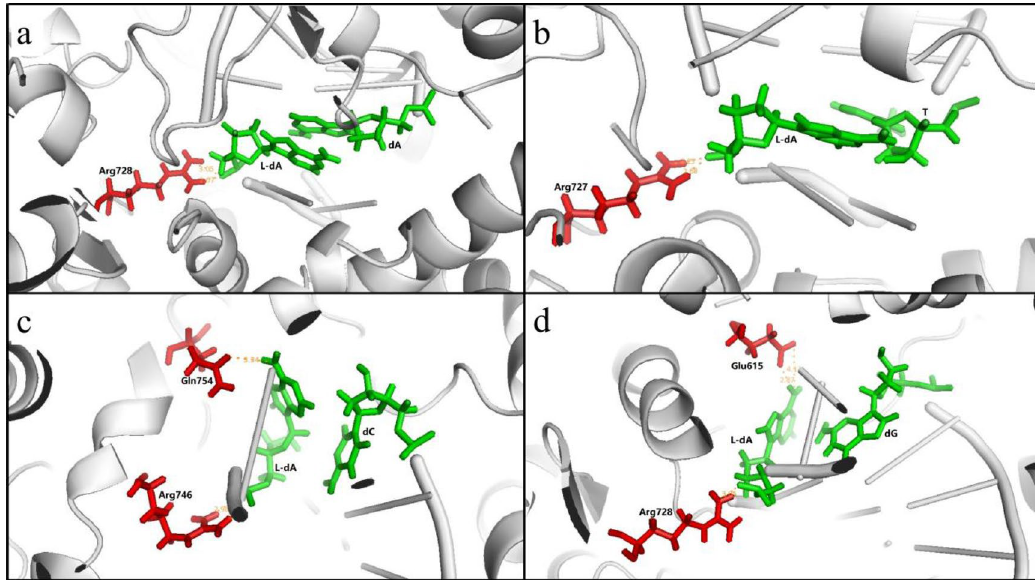
Figure 7. The cognate and non-cognate nucleotide insertion opposite to l-dA by Taq DNA polymerase. ( a ) l-dA:dA, ( b ) l-dA:T, ( c ) l-dA:dC, ( d ) l-dA:dG. Nucleotide pairs were shown in green, neighbouring amino acid residues were shown in